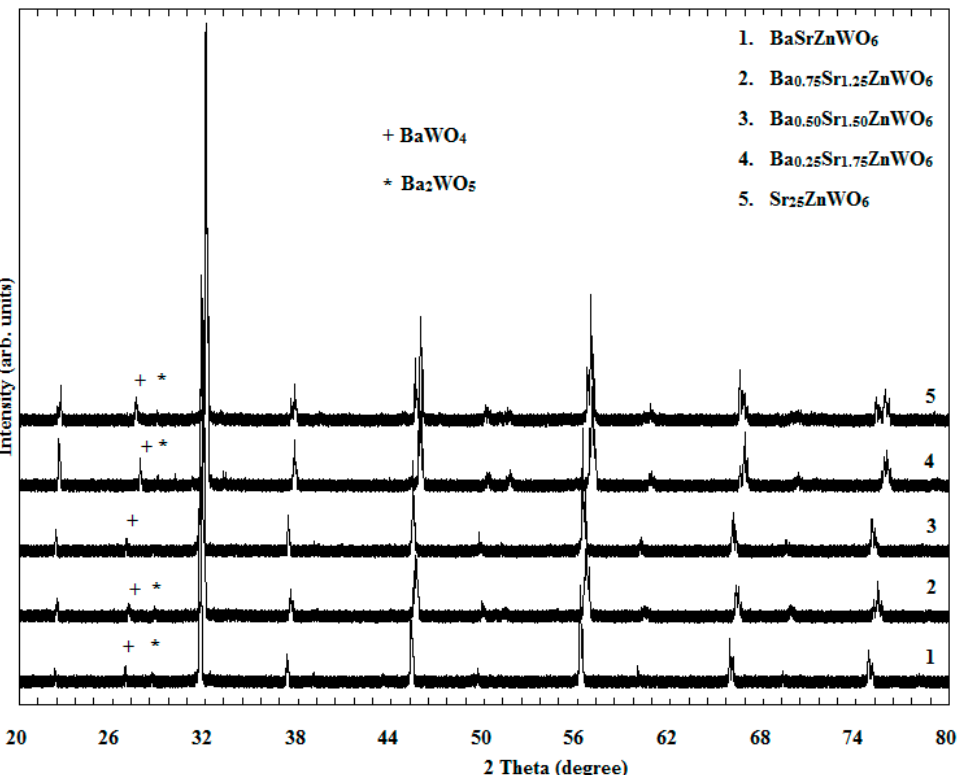
Figure 1. X-ray powder diffraction of the Ba 2 − x Sr x ZnWO 6 (x = 1, 1.25, 1.50, 1.75, 2) double perovskite series.